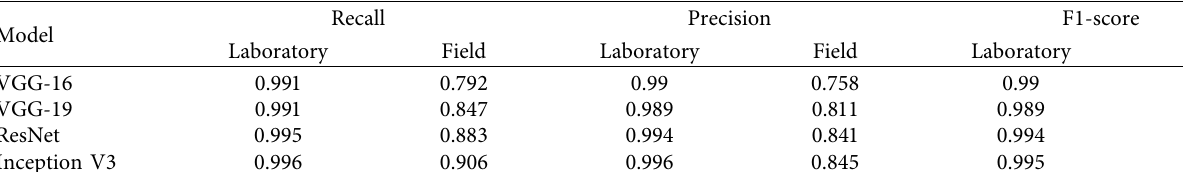
Table 5: Recall, precision, and F1-score using